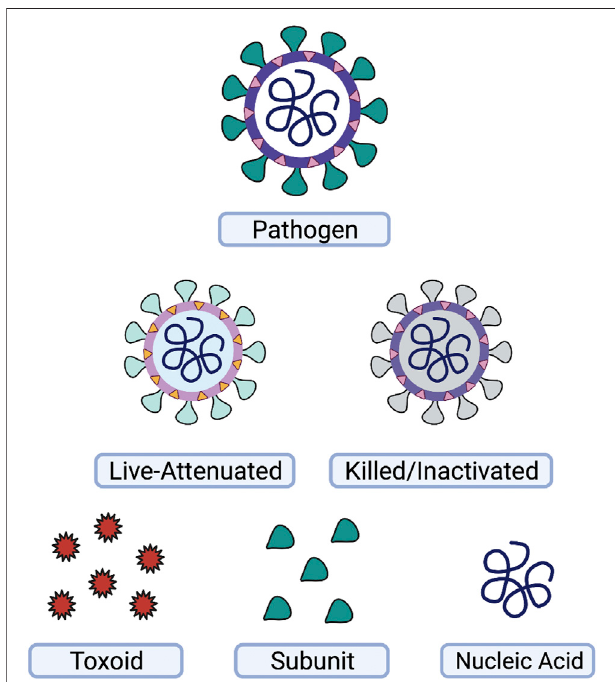
FIGURE 1 | Types of vaccines. A wide variety of vaccines have been used for prevention of disease. Vaccines may be based on the whole- pathogen, such as live-attenuated or killed-inactivated vaccines, or on subsetsofthepathogen,suchastoxinsorproteinsubunitsproducedby thepathogen.NucleicacidvaccinesutilizingDNAorRNAareanotherstrategy for vaccine development. This fi gure was generated using Biorender.com.